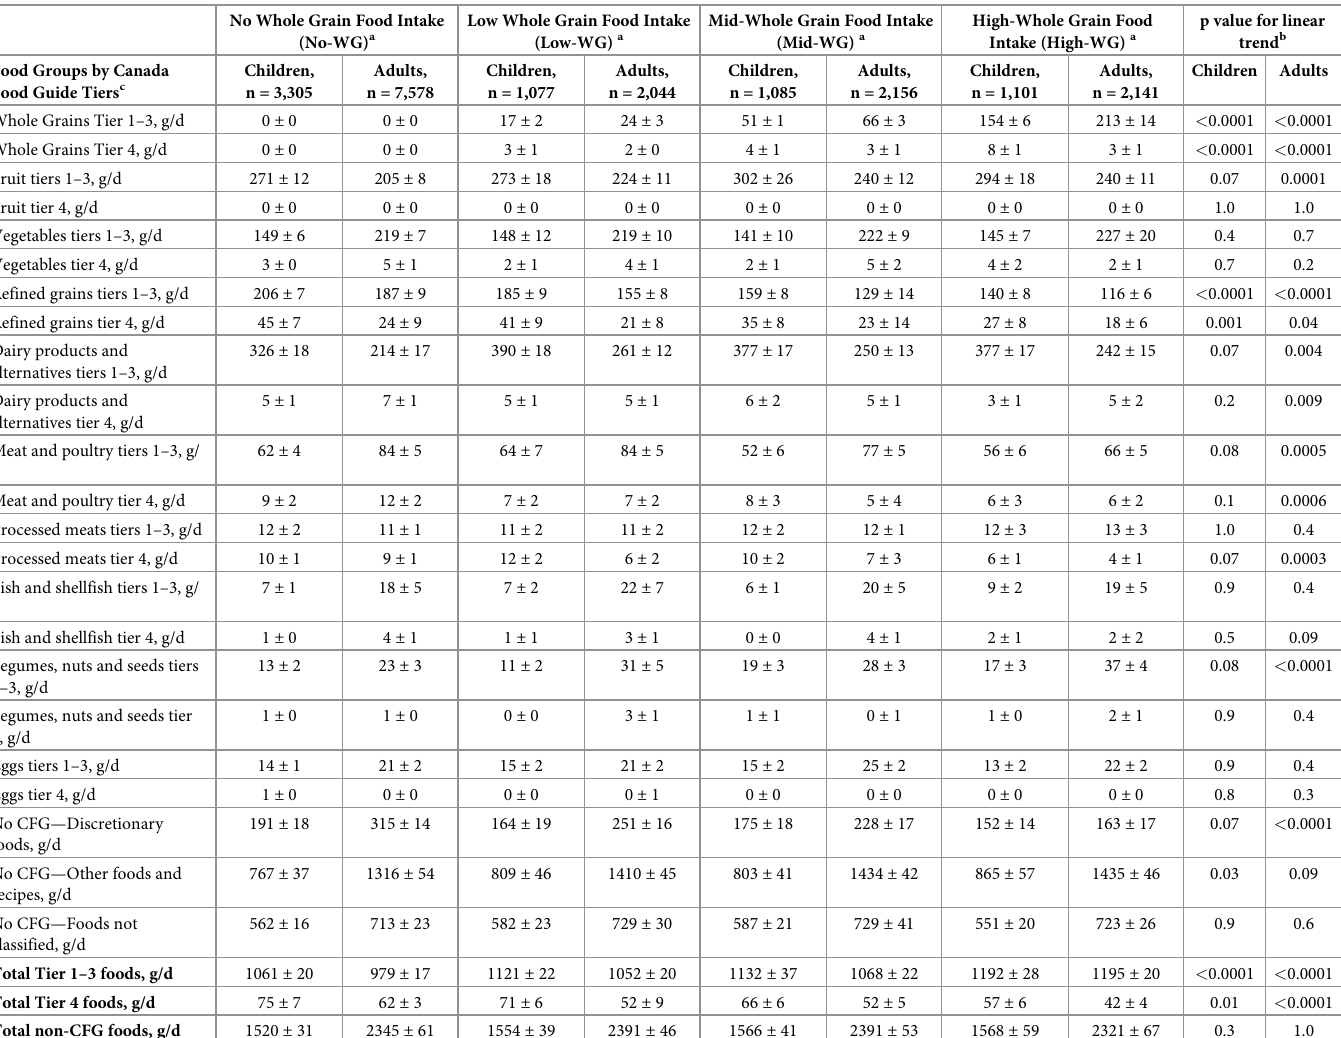
Table 3. Adjusted Canadian food guide food group intake for children and adults stratified by whole grain food